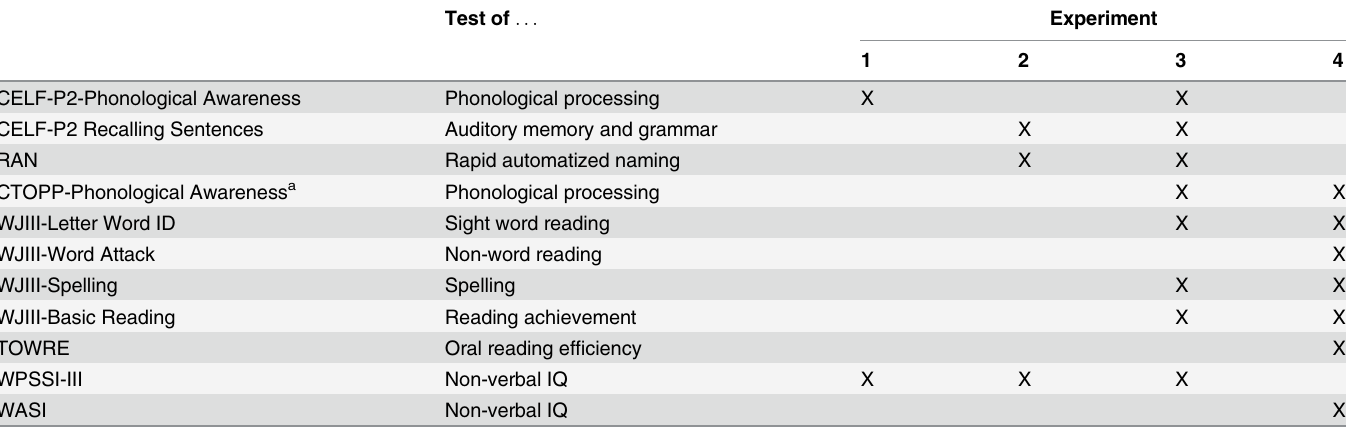
Table 2. Behavioral test battery for each experiment.